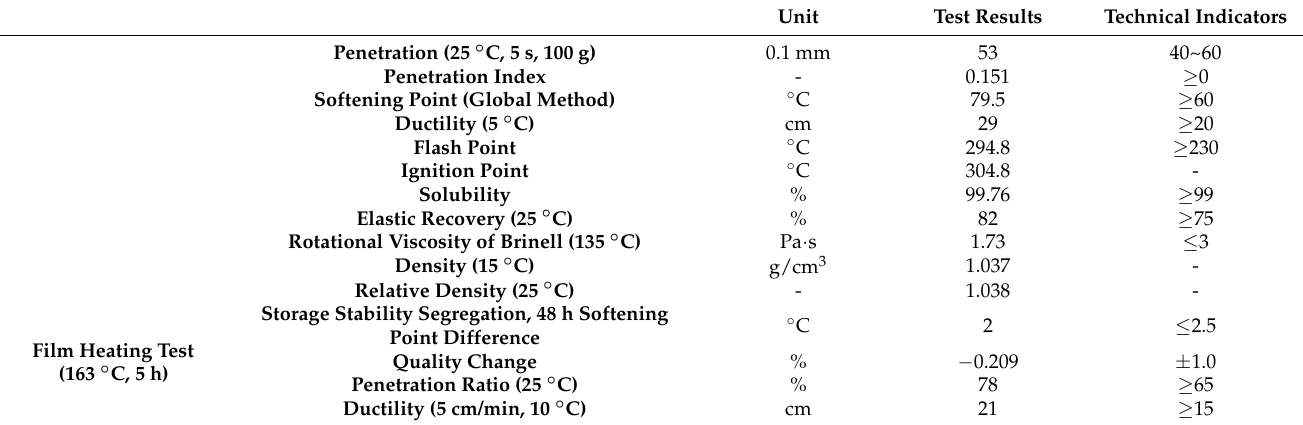
Table 4. Test results of SBS polymer-modified